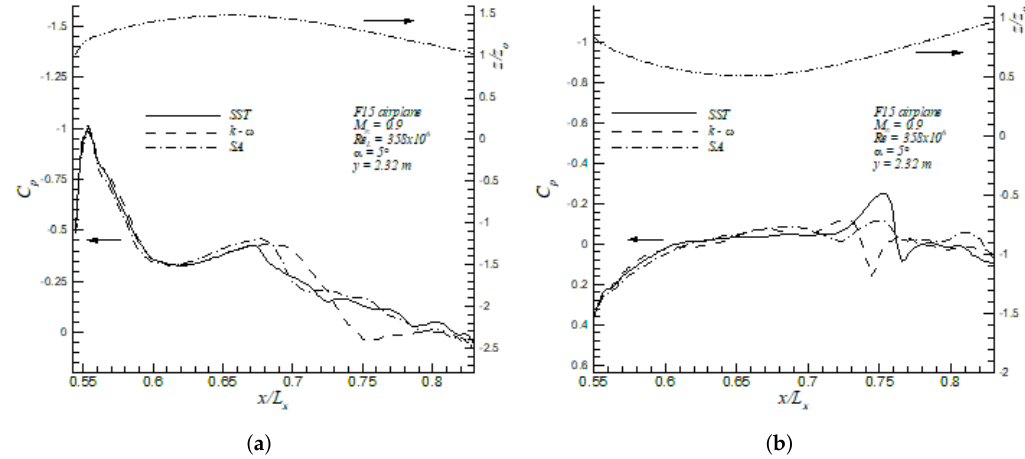
Figure 18. Pressure coefficients of F15 in the upper ( a ) and lower ( b ) surfaces at y / L y =